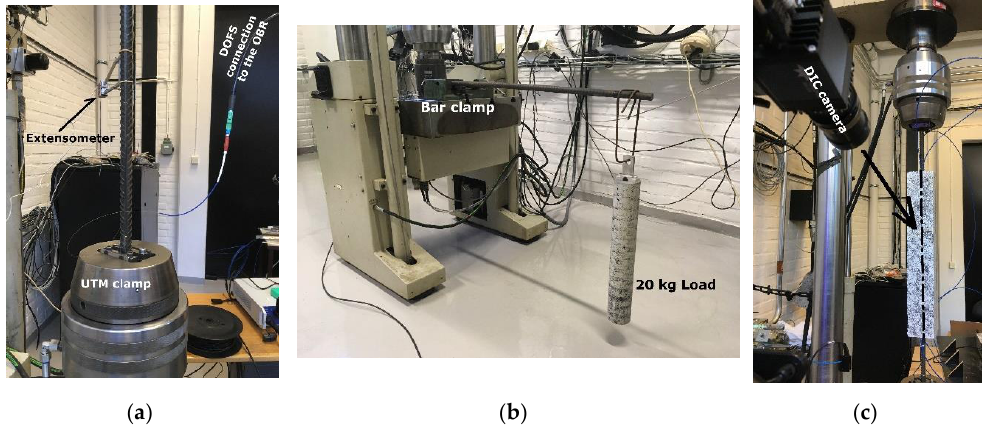
Figure 6. Test setup for the ( a ) universal testing machine (UTM)-assisted tensile test on a bare rebar ( b ) bending test ( c ) UTM and digital image correlation (DIC)-assisted tensile test on a RC tie.